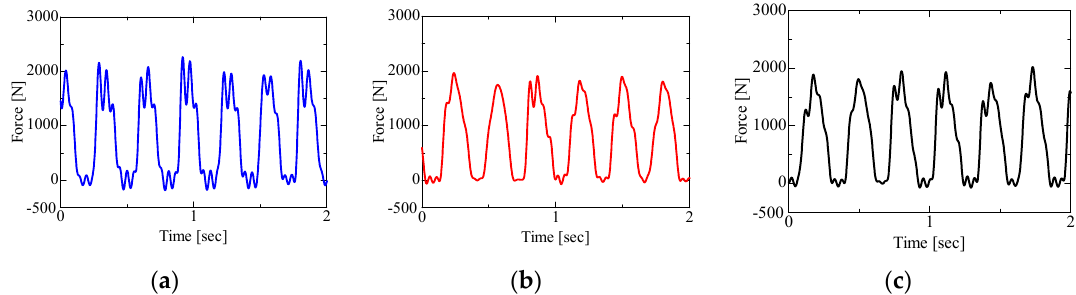
Figure 4. Results for vertical force in running conditions: ( a ) low target load; ( b ) medium target load; ( c ) constant belt speed.